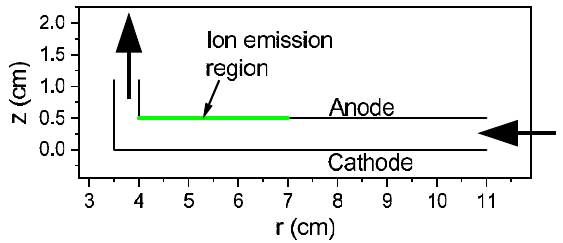
FIG. 1. Schematic of the 2D simulation geometry. Electromag- netic power and the electron sheath are injected radially at the r ¼ 11 cm inlet boundary. The transmission line is terminated at z ¼ 1 cm by a fixed impedance